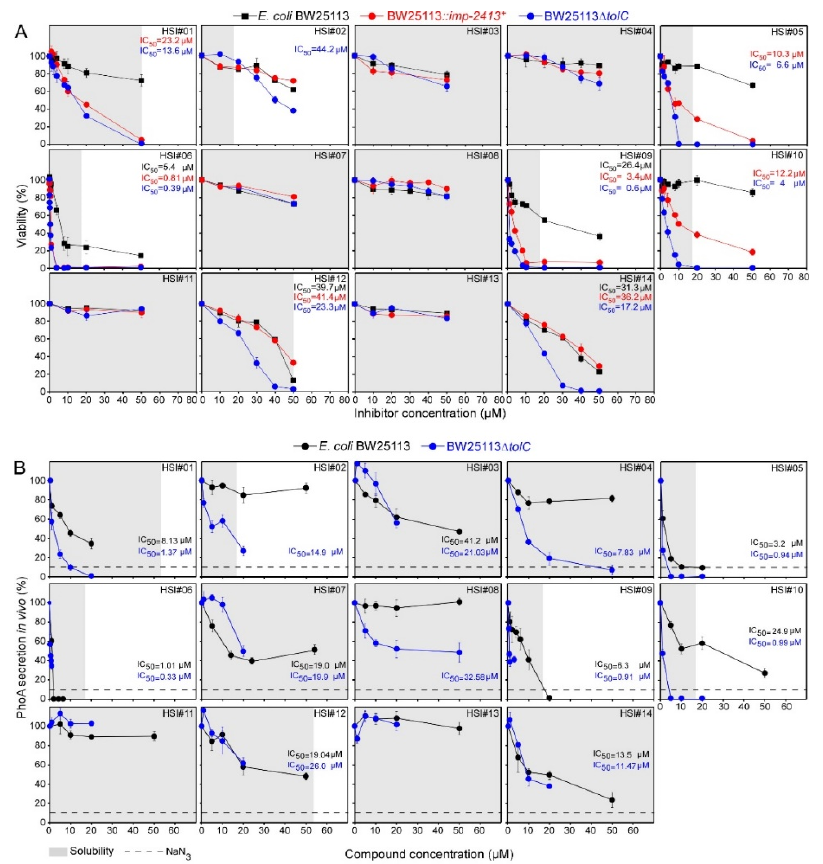
Figure 5. Antibacterial activity and in vivo PhoA secretion inhibition toward E. coli strains and derivatives. ( A ). Antibacterial activity toward E. coli BW25113 and its derivatives BW25113 ΔtolC and BW25113 ::imp-2413 + of the indicated 14 inhibitors isolated from the HTS screening. n = 3. Results are presented as the mean ± SEM. Gray shade: aqueous solubility. ( B ). The effect of the 14 compounds isolated from the HTS screening on PhoA secretion in vivo of the indicated strains tested using the p-nitrophenyl assay (as in Figure 2A). The SecA inhibitor sodium azide (4 mM) [26] was used as a positive inhibitory control for maximal SecA inhibition observable in vivo (dashed line). Gray shade: aqueous